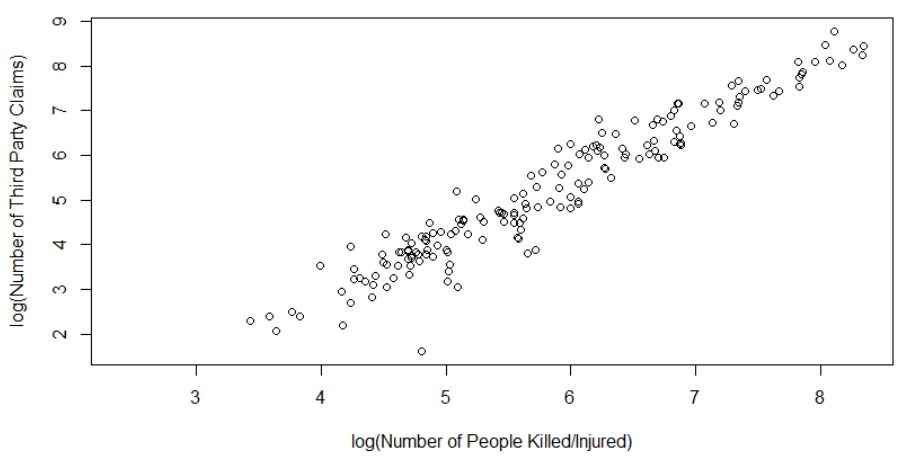
Figure 8. Scatterplot of the Model 4 data (on a natural log scale).